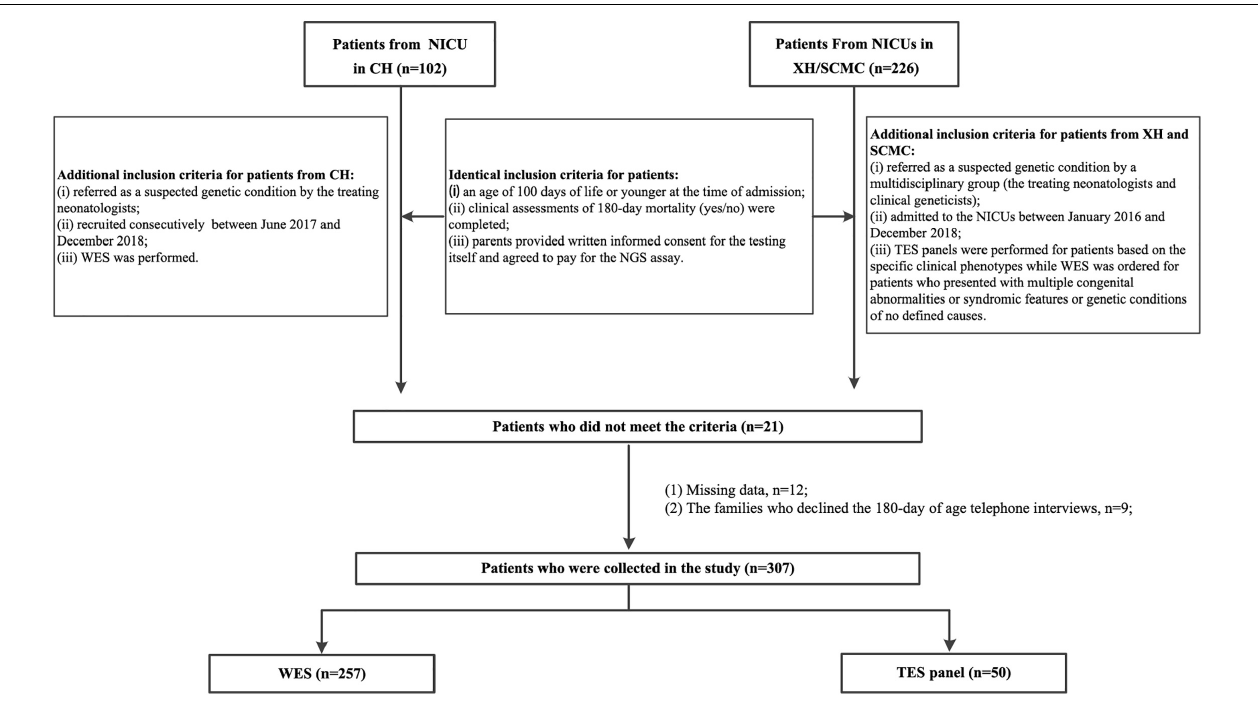
FIGURE 1 | Patient flowchart. XH: Xinhua Hospital, Shanghai Jiao Tong University School of Medicine; CH, Children’s Hospital, Shanghai Jiao Tong University School of Medicine; SCMC, Shanghai Children’s Medical Center, Shanghai Jiao Tong University School of Medicine; NICU, Neonatal Intensive Care Unit; NGS, next-generation sequencing; TES, targeted exome sequencing; WES, whole-exome